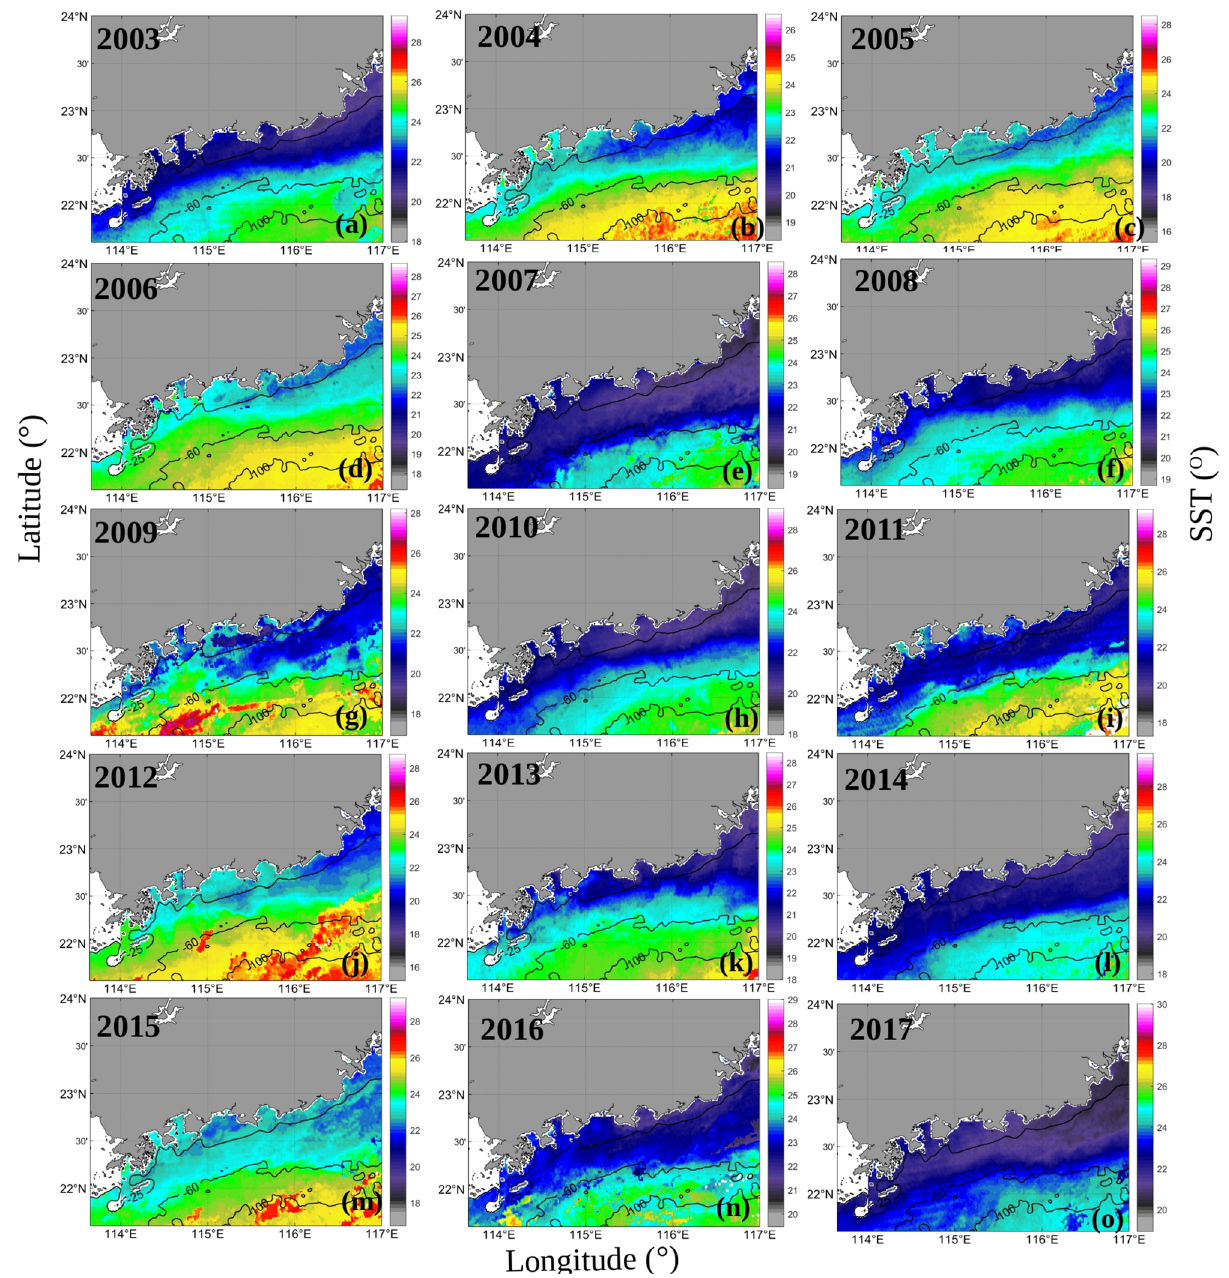
Figure 8. The mean SSTs between November and December from 2003 to 2017. The program R (version 3.6.3, available at https:// www.r- proje ct. org) was applied for the